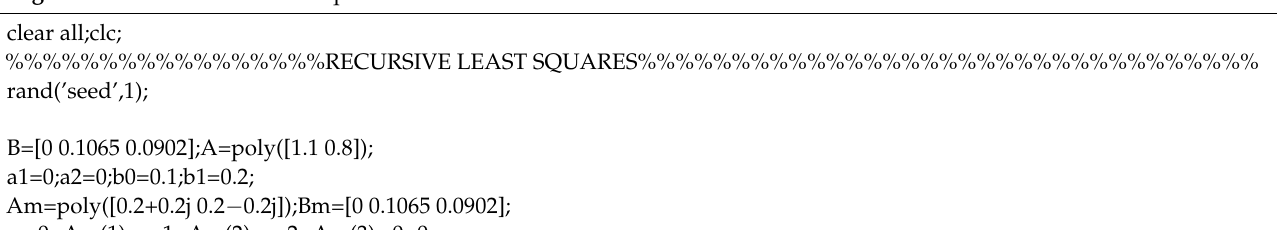
Algorithm A1 Recursive Least